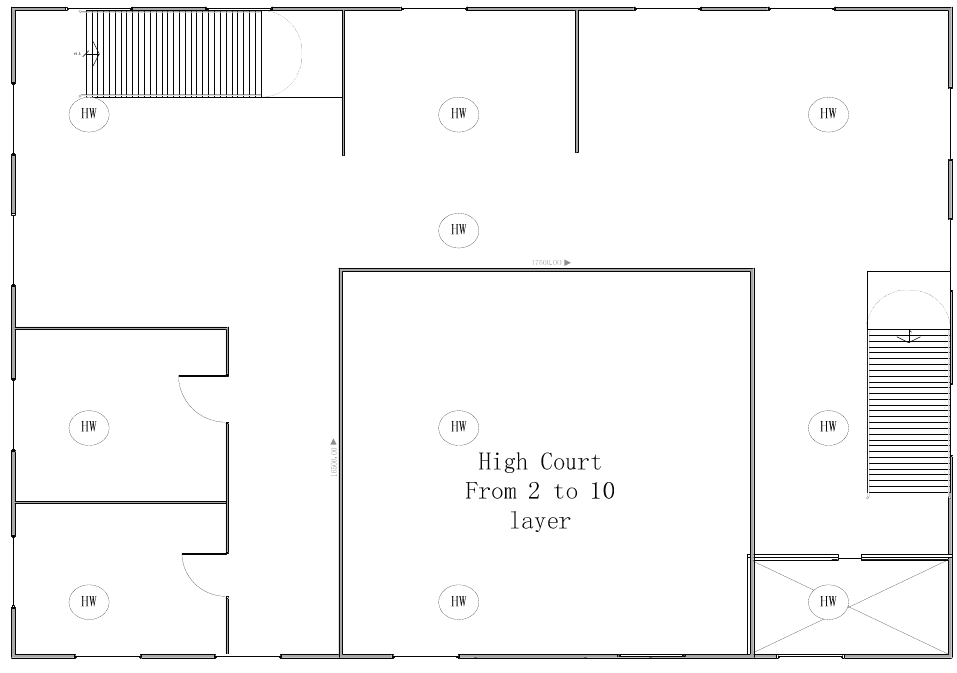
Figure 9. The Second to the 10th layer plane